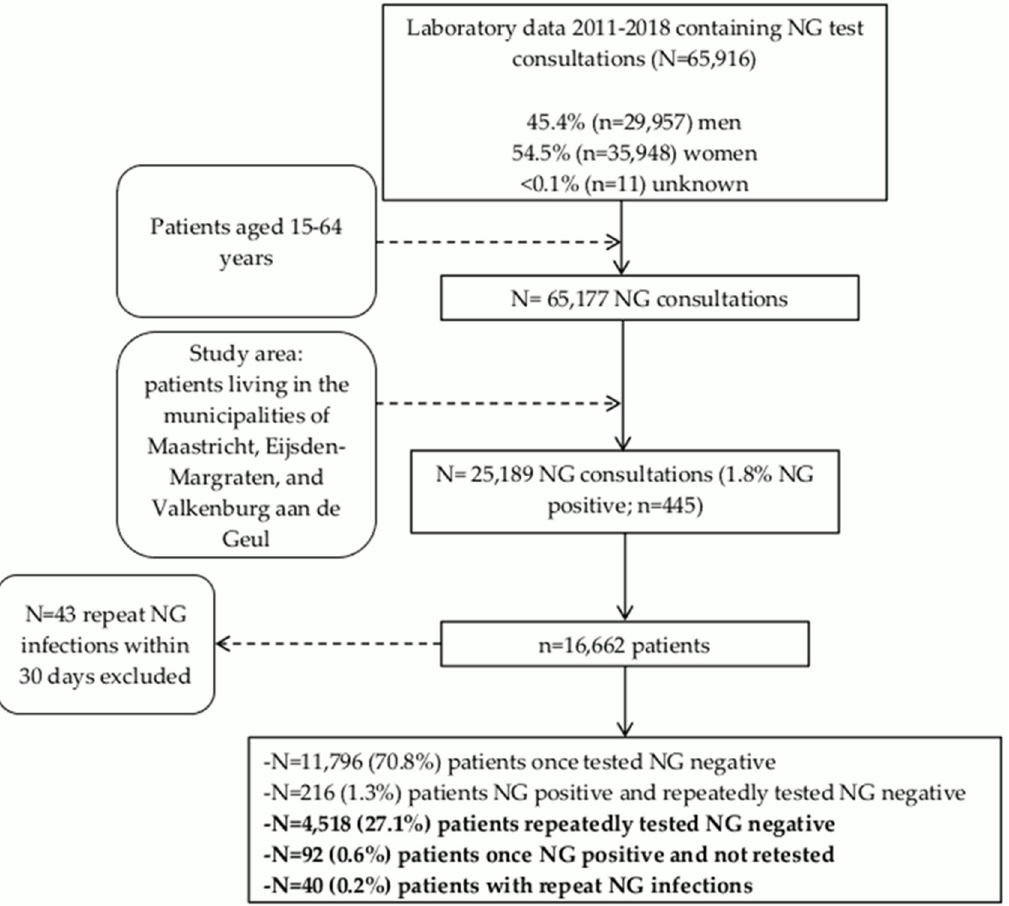
Figure 1. Flowchart of Neisseria gonorrhoeae test consultations, January 2011- July 2018.